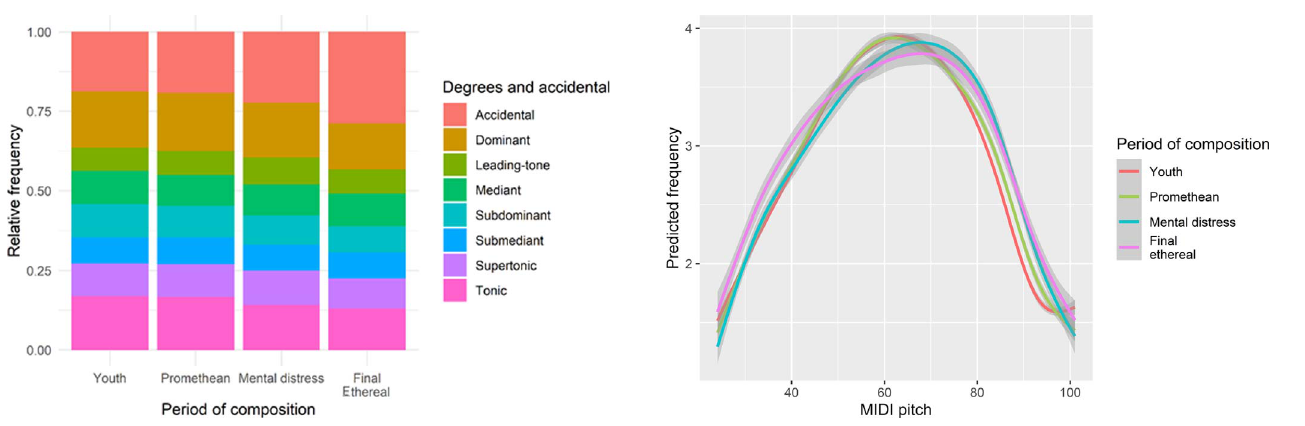
Figure 4. Frequencies of the pitches occurrence and their 95% con fi dence interval predicted by the model according to their MIDI classi fi cation and the four periods of